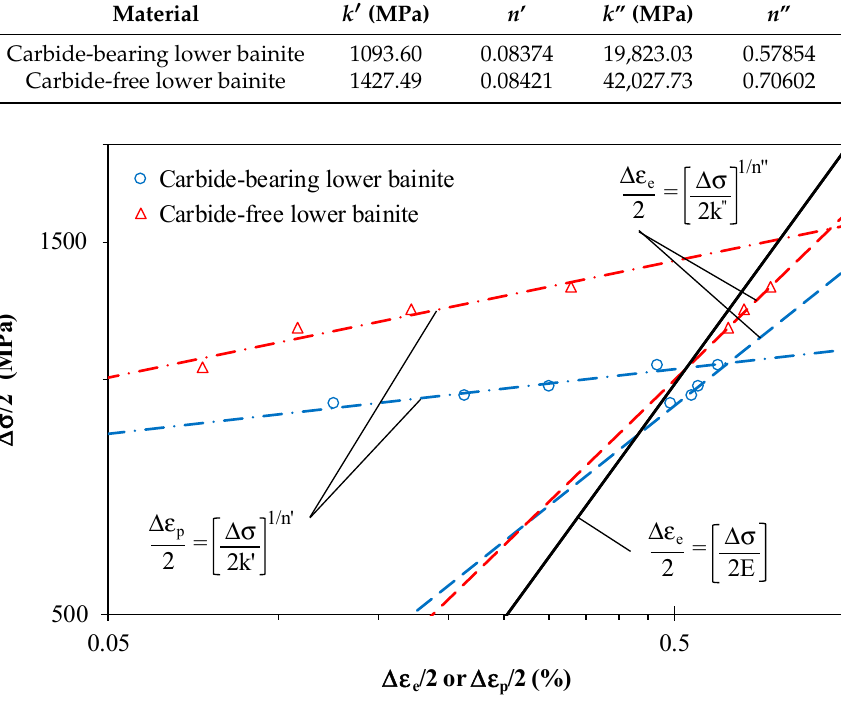
Figure 6. Stress amplitude versus elastic strain amplitudes on the basis of both of the unloading Young’s moduli that were evaluated in the tests (dashed lines) and the Young’s modulus that was determined from the monotonic tensile test (solid lines).